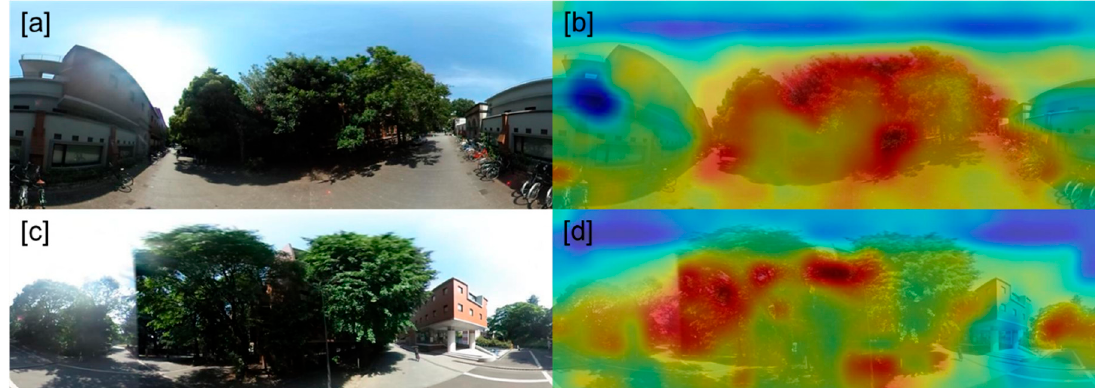
Figure 10. The class activation map of the binary classification of tree and non-tree images with ResNet-50. The panels ( a ) and ( c ) show the original image of the 360° spherical camera. The panels ( b ) and ( d ) illustrate the class activation map. The maps were created based on [51]. The red and blue colors indicate the higher and lower activation, respectively.